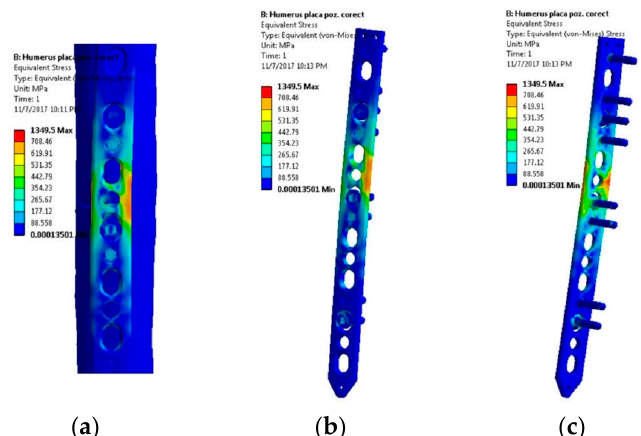
Figure 11. Stress distribution within the LCP when a 200 N transversal joint force acts: ( a ) Lateral view, bone-plate; ( b ) Lateral-front view, plate-screws; ( c ) Lateral-back view, plate-screws.